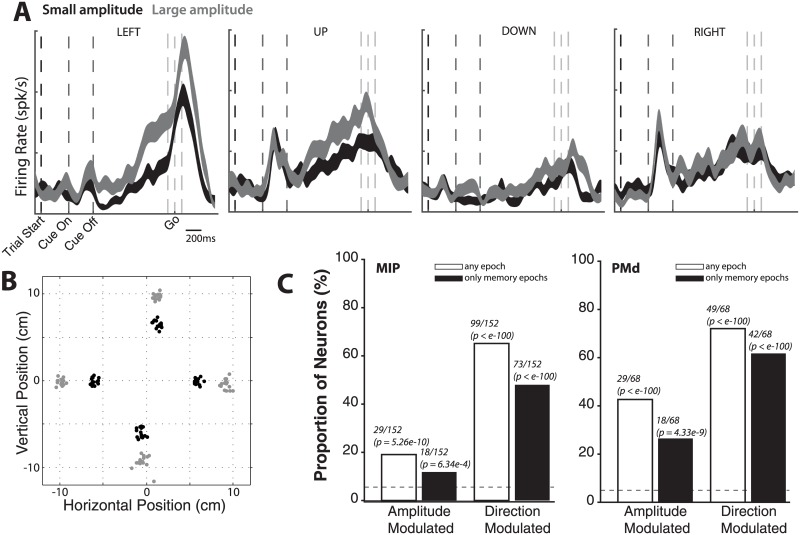
(A) Example neuronal data. For an example neuron recorded under Task 1, the spike density functions (mean ± SE) for small and large amplitude is shown (small and large amplitude are shown in grey and black respectively). Each panel corresponds to a reach direction. Vertical lines mark trial events; the go signal is shown as mean +- SE due to the randomized length of the memory period (see dashed line). Axes are identical for the four panels. For this neuron, we observe significant modulation of memory period spiking activity by reach amplitude in some but not all directions. (B) Example behavioral data from one session. The endpoint of reaches to target in Task 1 are shown. For visual clarity, 15 trials for each target are shown. Small and large amplitude are shown in grey and black respectively. (C) Population analysis of modulation by reach direction and amplitude for both tasks. The proportions of task-related MIP and PMd neurons with significant main or interaction effects of reach amplitude (and reach direction), in any of the four trial effects (p < 0.05/8 with Bonferroni correction for eight comparisons across effect types and epochs; 2-way ANOVA interaction model) are shown (white bars), along with the “null” proportion expected by chance (dashed line). The corresponding proportions when considering only movement planning epochs (p < 0.05/4, Bonferroni correction for four comparisons), are also shown (black bars).